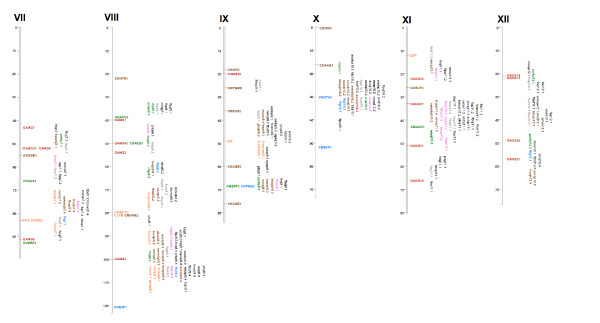
Quantitative Trait Loci (QTL) positioned in the melon integrated map. Linkage groups VII to XII. Color codes are indicated in Figure 3.